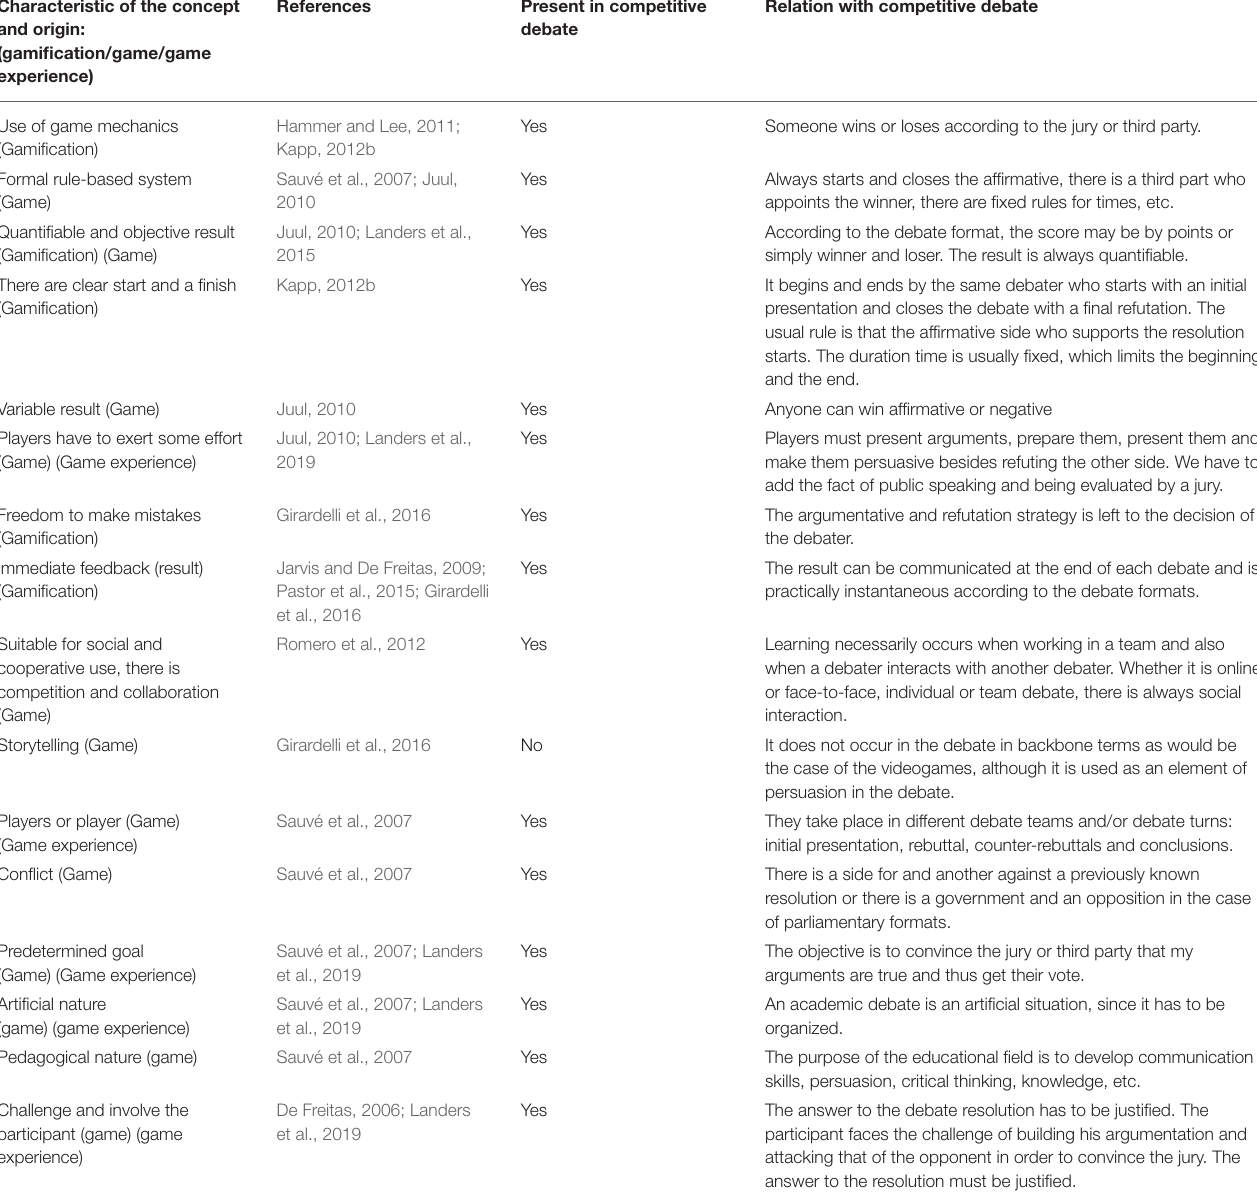
TABLE 4 | Characteristics of gamification/game/game experience related to competitive